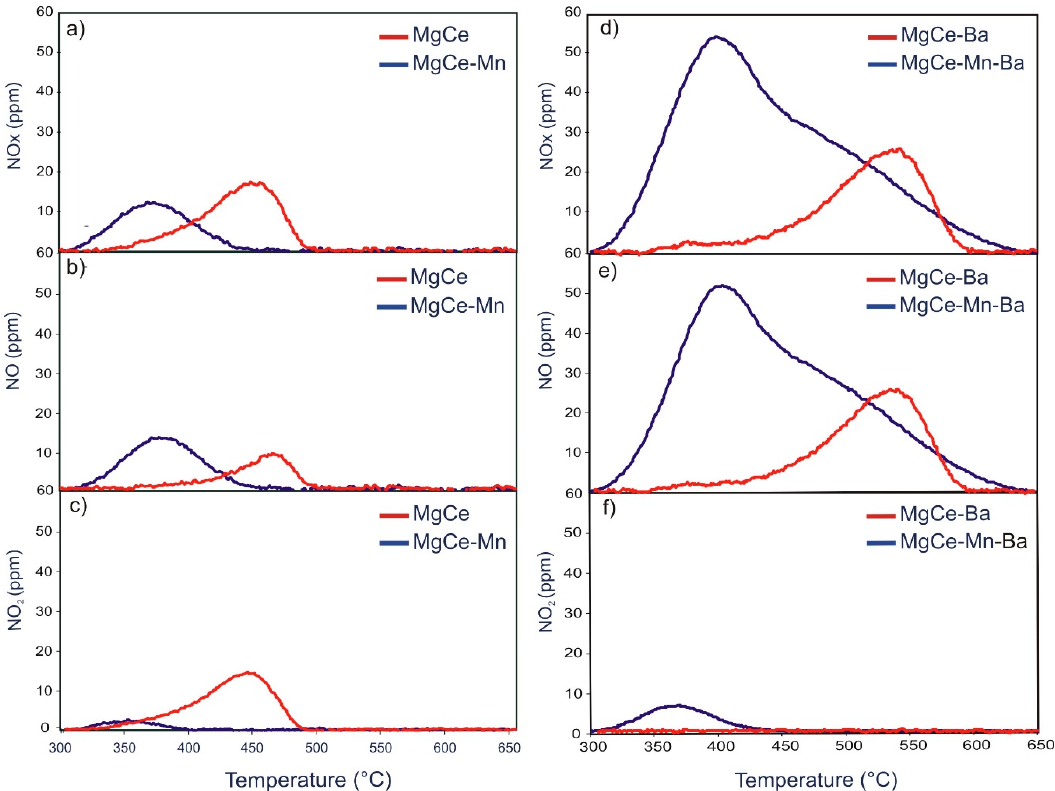
Figure 5. TPD profiles (single-bed configuration) of MgCe and MgCe-Mn ( a ) NO x , ( b ) NO ( c ) NO 2 and MgCe-Ba and MgCe-Mn-Ba ( d ) NO x , ( e ) NO ( f ) NO 2 . Table 7. Released amounts of NO x , NO and NO 2 after adsorption under single-bed configuration.